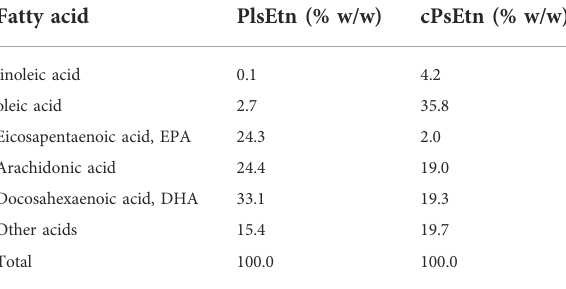
TABLE1Fattyacidcompositionofplasmalogenspuri fi edfromscallop (PlsEtn) and chicken